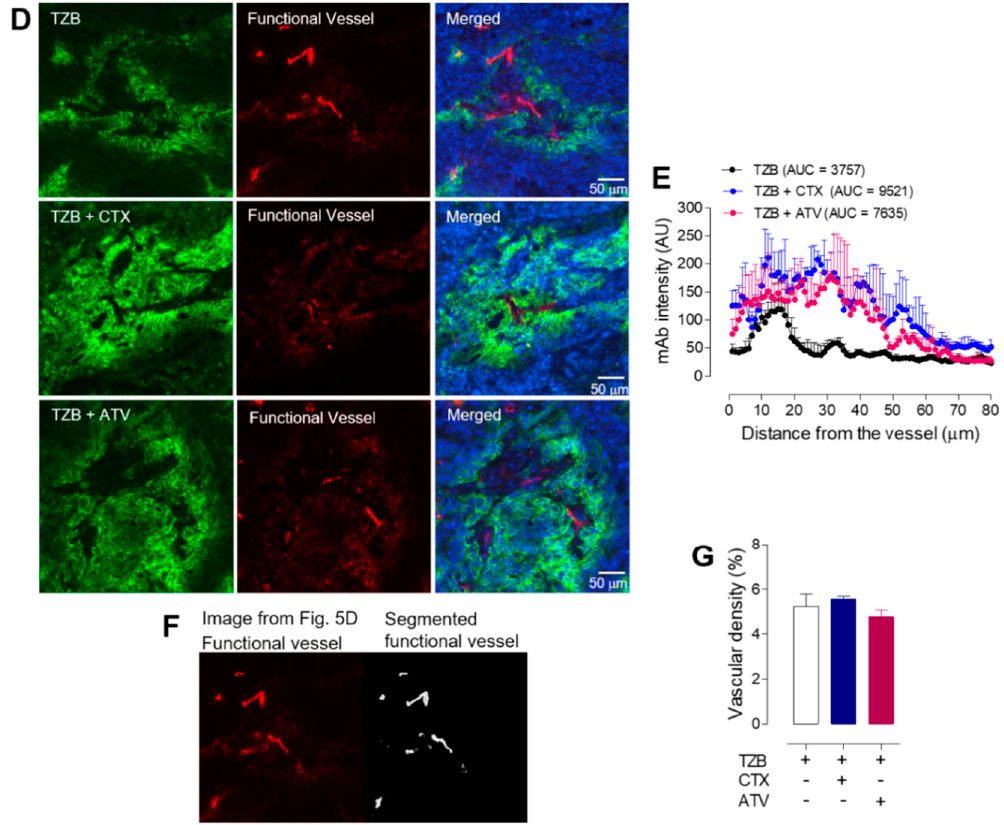
Figure 5. Effect of ATV on TZB accumulation in the tumor tissue. ( A ) The experimental design of TZB penetration into tumors. ( B ) In vivo localization of Alexa-488-TZB in NCI-N87 tumor tissue (scale bar = 500 µ m). ( C ) Alexa-488-TZB accumulation per tumor tissue area (** p < 0.005), ( D ) In vivo penetration of Alexa-488-TZB after co-administration with ATV in NCI-N87 tumor tissue. Representative images of Alexa-488-TZB (green), a rhodamine-lectin stained functional blood vessel (red), and green and red merged with DAPI staining (blue) (scale bar = 50 µ m). ( E ) In vivo penetration of Alexa-488-TZB is represented by histograms of Alexa-488 fluorescent intensity. ( F ) Images of functional vessel and segmented functional vessel. ( G ) Density of rhodamine-lectin positive functional blood vessel (N.S.). ATV, atorvastatin. TZB, trastuzumab. CTX, cyclophosphamide. ( n = 7 per group).